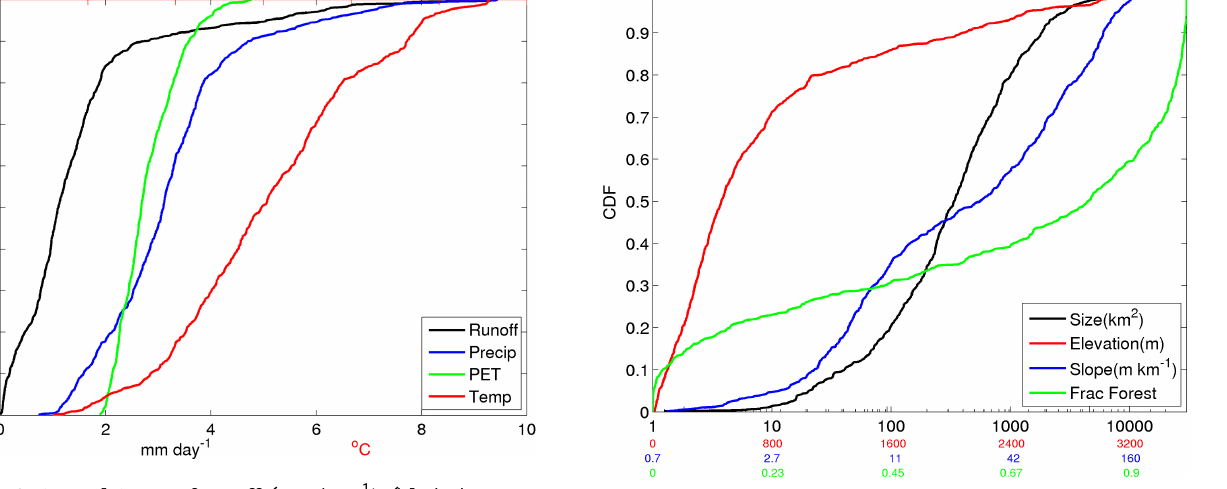
Figure 3. Cumulative density functions of basin size (km 2 ) (black), basin mean elevation (m) (red), mean slope (mkm − 1 ) (blue), and fractional forest cover (green) for the basin